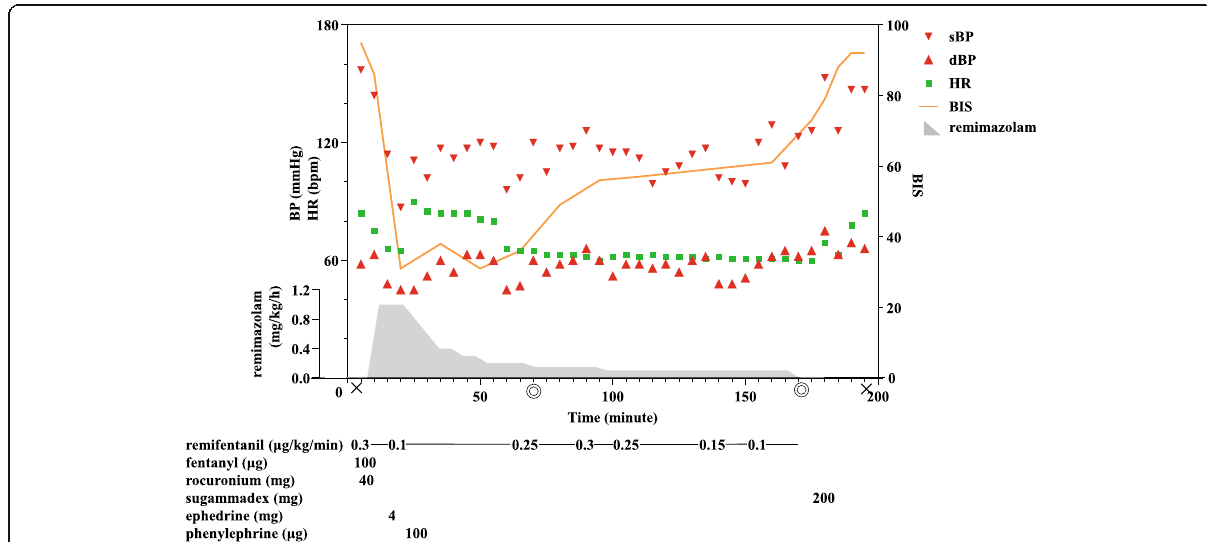
Fig. 2 Anesthetic chart for case 2. Double circles and crosses represent the start/end of surgery and start/end of anesthesia, respectively. sBP, systolic blood pressure; dBP, diastolic blood pressure; HR, heart rate; BIS, bispectral